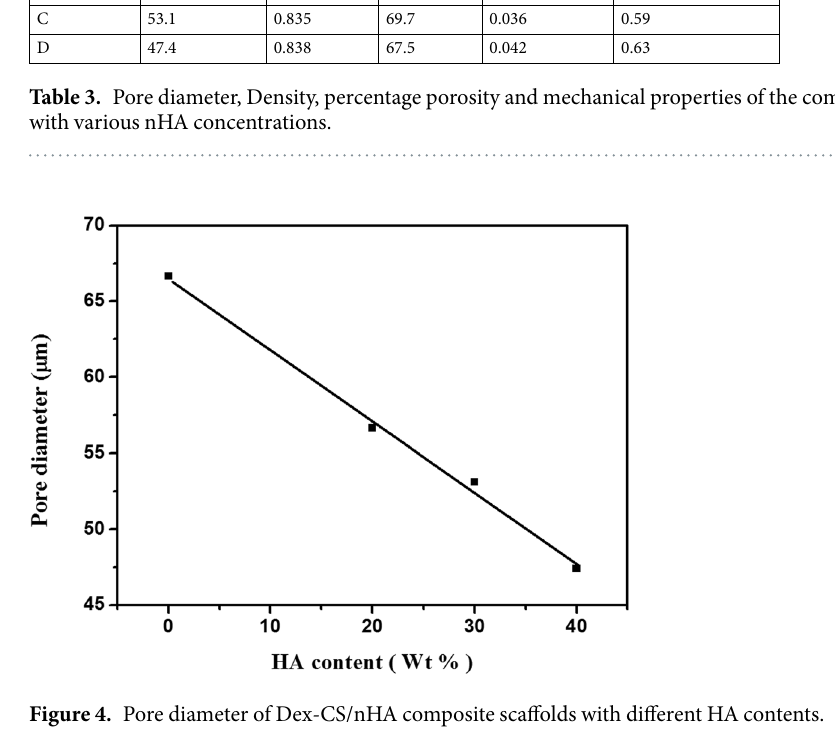
Figure 4. Pore diameter of Dex-CS/nHA composite scaffolds with different HA contents.